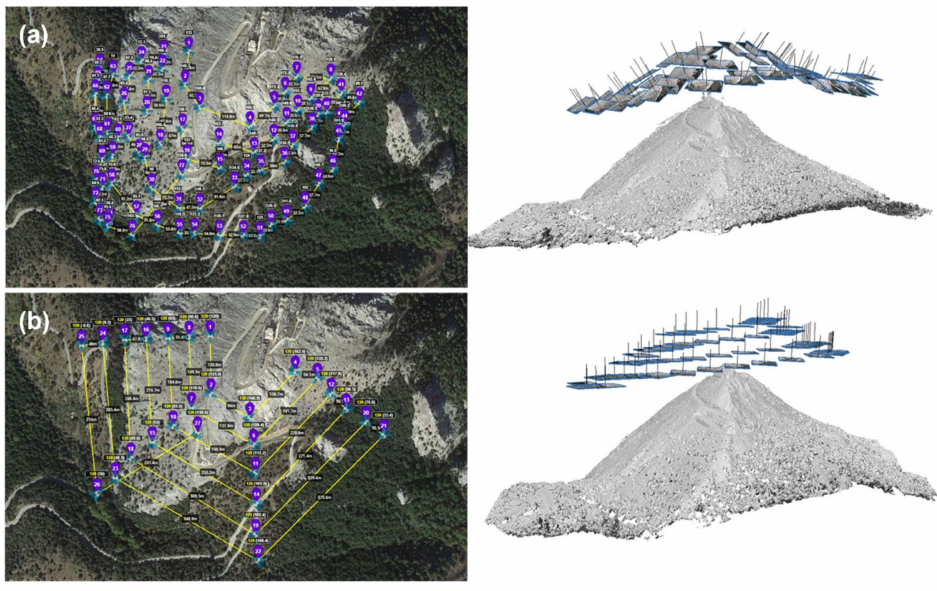
Figure 4. The flight path which followed the UAV ( a ) in case A and ( b ) in case